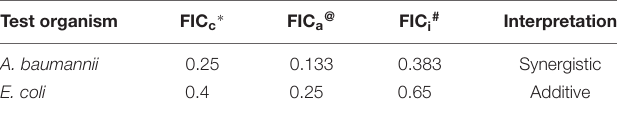
TABLE 8 | FIC index of individual curing agents and in combination with antibiotics.